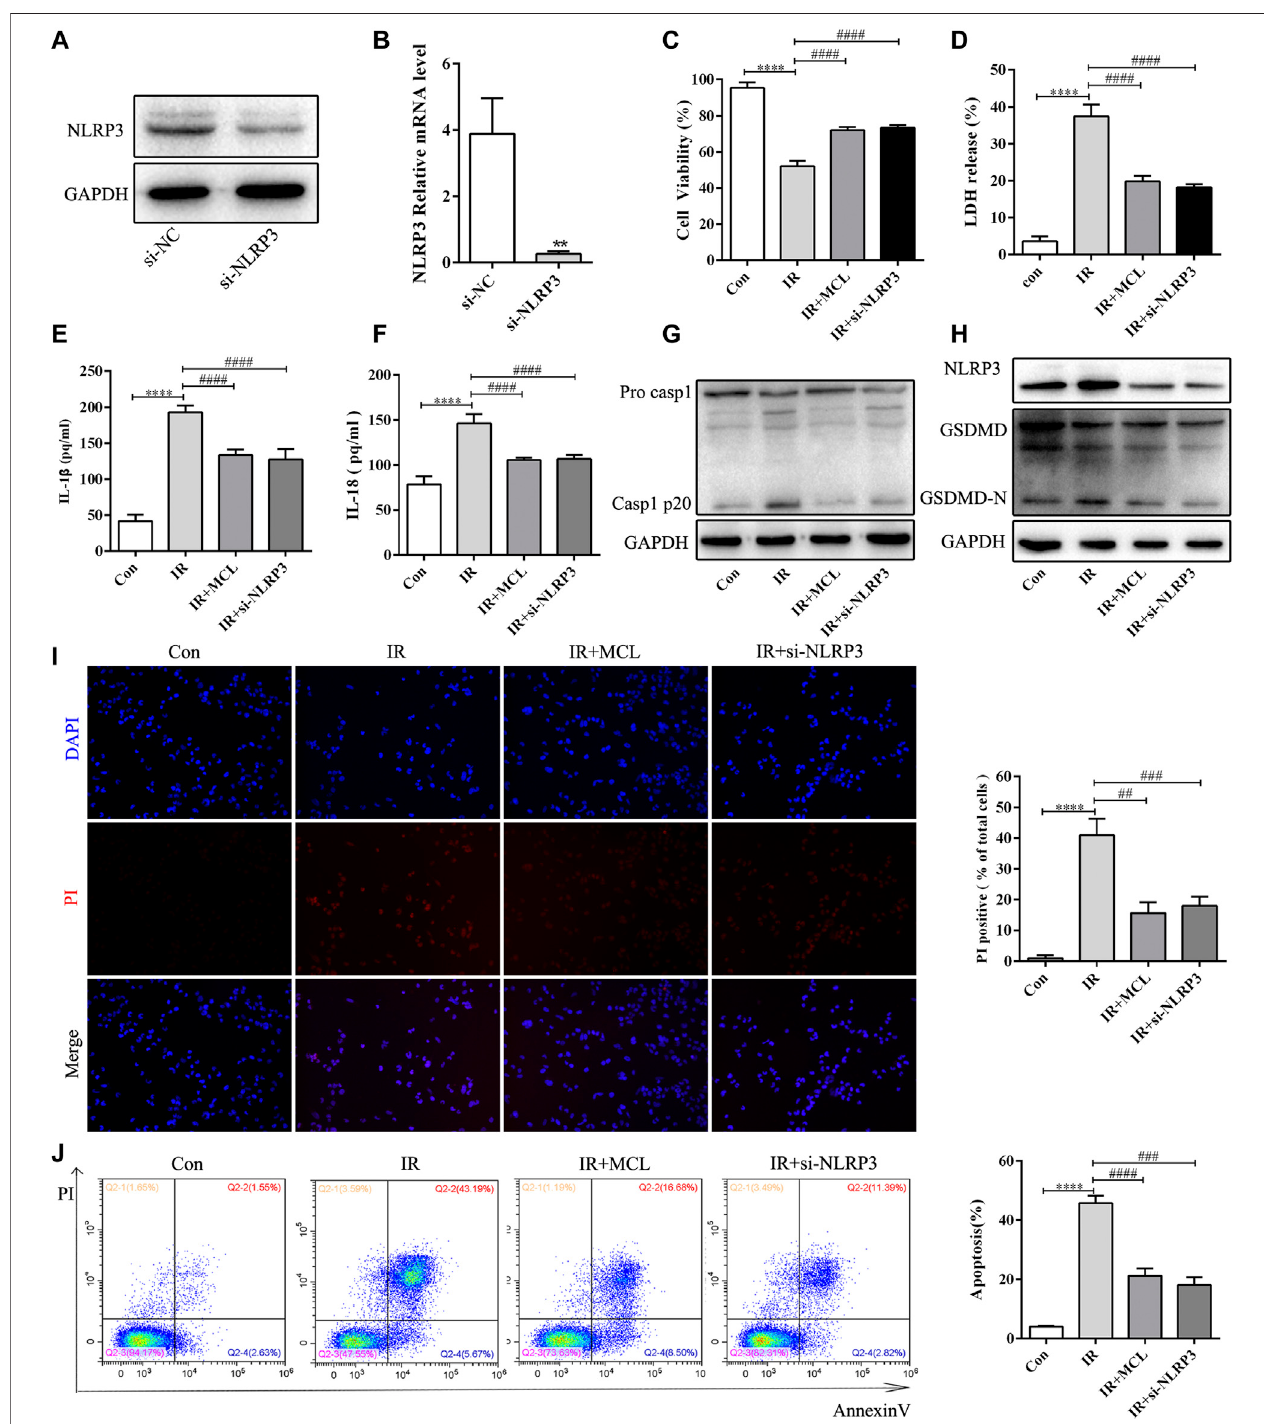
FIGURE 3 | Micheliolide (MCL) inhibits radiation-induced NLRP3 in fl ammasome-dependent pyroptosis in vitro (A,B) Expression of NLRP3 in control (Ctl) and NLRP3-silenced (si-NLRP3) cells was detected by western blotting and quantitative real-time polymerase chain reaction (C) Cell viability was signi fi cantly increased by MCL (10 μ M) treatment and NLRP3 knockout manner following treatment with radiation (10 Gy) for 48 h (D) LDH release was signi fi cantly decreased by MCL (10 μ M) treatmentandNLRP3knockoutmannerfollowingtreatmentwithradiation(10 Gy)for48 h (E) CellculturesupernatantIL-1 β levels (F) CellculturesupernatantIL-18 levels (G,H) Expression of pro-casp1, casp1 p20, NLRP3, GSDMD, and GSDMD-N in si-NLRP3 cells and si-NC cells treated with MCL (10 μ M) following irradiation (10 Gy) (I) Representative propidium iodide staining fl uorescence image (J) Representative fl ow cytometry scatter plots. * p < 0.05, ** p < 0.01, *** p < 0.001, **** p < 0.0001, two-tailed Student ’ s t-test. IL, interleukin; NLRP3, nucleotide binding domain leucine-rich repeat-containing receptor-pyrin domain containing three; GSDMD, gasdermin D.